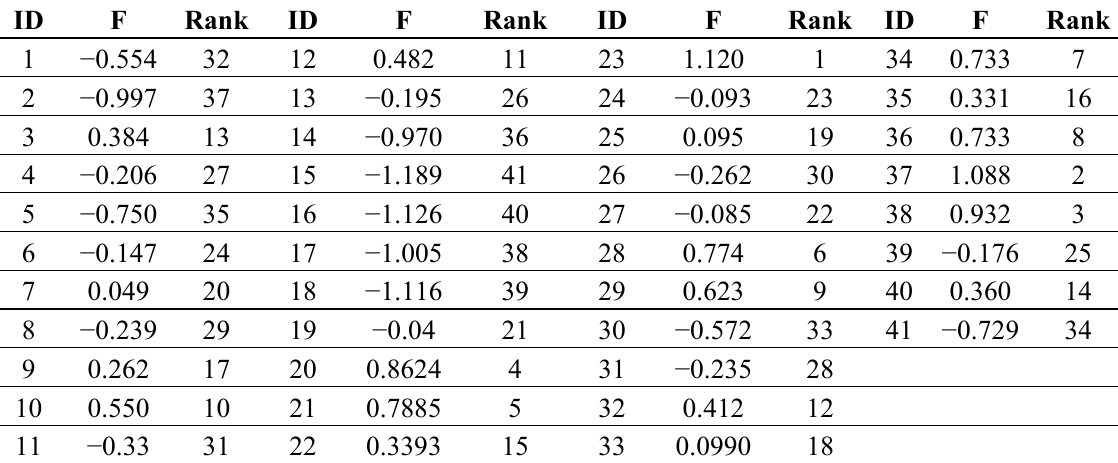
Table 5. Overall score of disaster resilience (F) and their rank in the hospital sample (data from Zhong et al. 2014